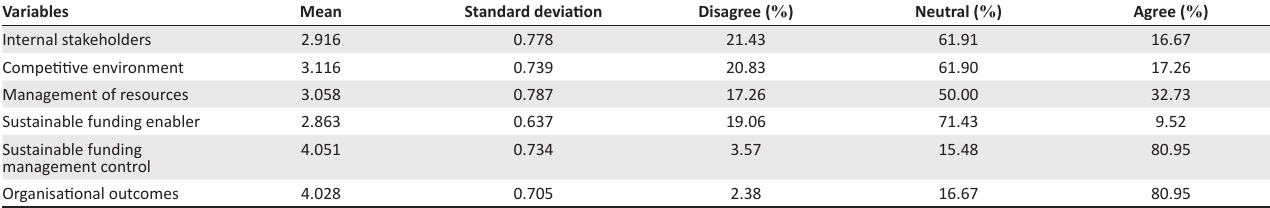
TABLE 2: Descriptive statistics of the variables.